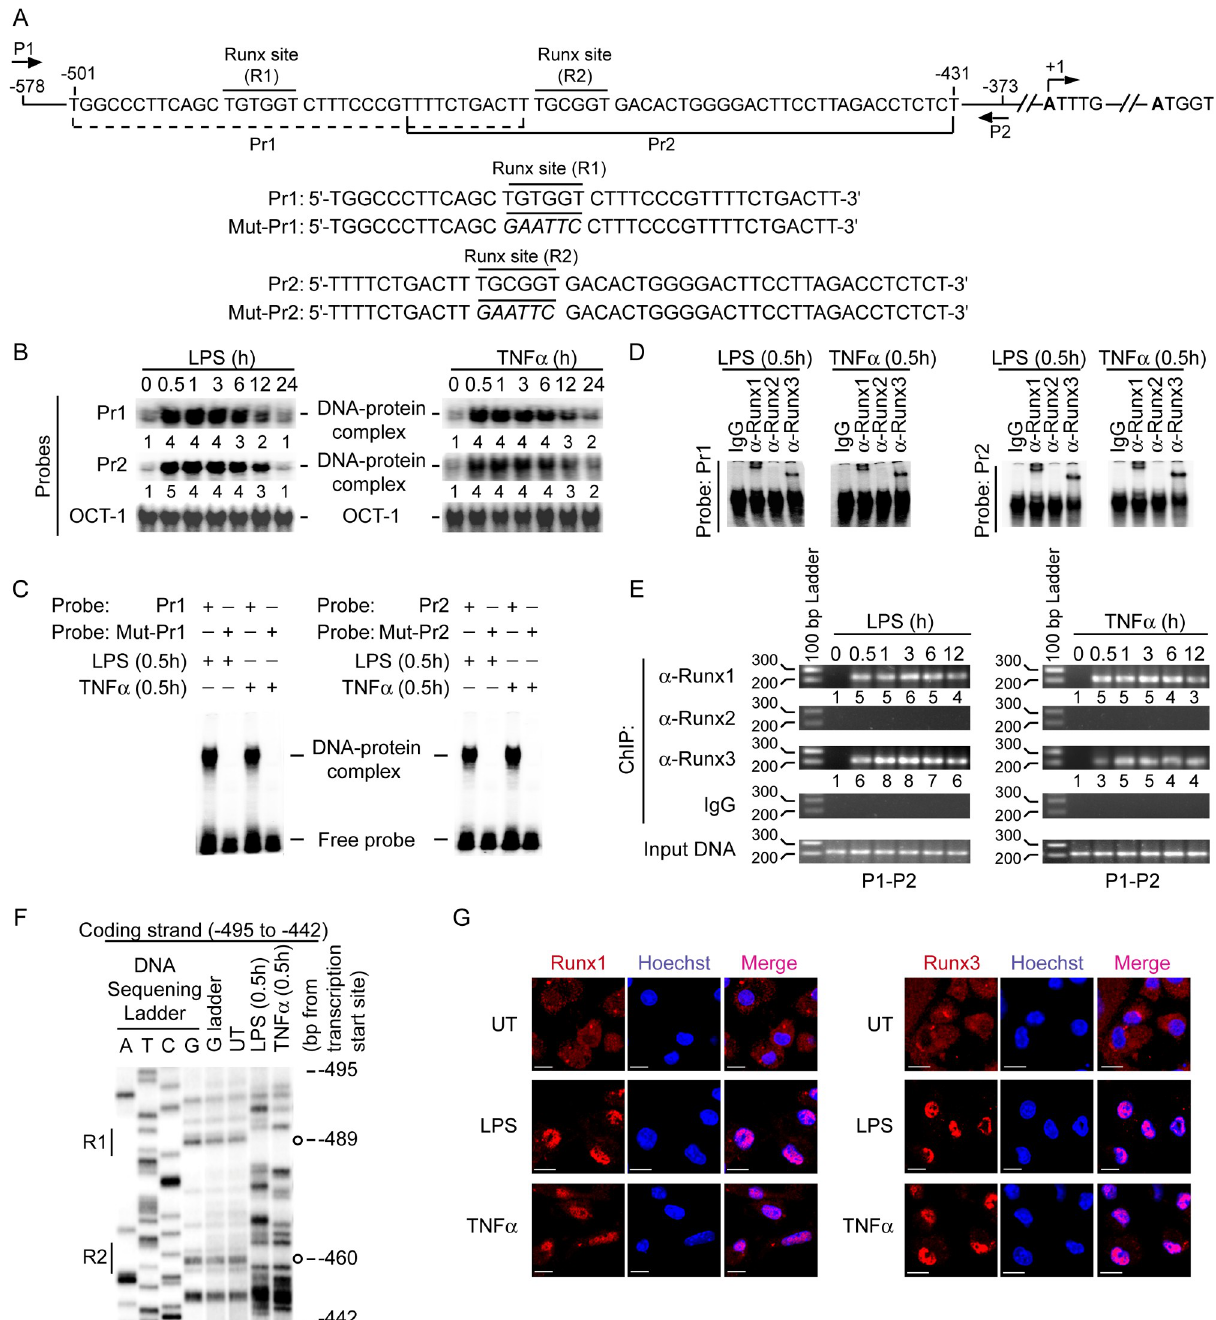
Fig 2. LPS and TNF α induce nuclear localization and binding of Runx proteins to the CD40 promoter. (A) Schematic presentation of mouse CD40 promoter indicating the location of putative Runx-binding sites (R1 and R2) and ChIP primers (P1 and P2), and details of oligonucleotide probes used for EMSA. Mouse CD40 promoter-specific Pr1 and Pr2 probes contain putative wild-type Runx-binding sites, and Mut-Pr1 and Mut-Pr2 probes contain mutations (in italics) at Runx-binding sites. Base positions are relative to the transcription start site. (B and C) EMSA of nuclear extracts of BMDCs treated with LPS or TNF α for indicated times; assessed with indicated probes. Numbers below lanes in (B) represent densitometry [normalized to OCT-1 binding (control)] relative to that of untreated BMDCs (0 h). The densitometry results pooled from three independent experiments for (B) are shown in S2 Fig. (D) Supershift EMSA [with immunoglobulin G (IgG; control) or antibody to ( α -) Runx1, Runx2 or Runx3] of nuclear extracts of BMDCs treated with LPS or TNF α for 0.5 h; assayed with Pr1 or Pr2 probes. (E) Binding of Runx proteins to -578/-373 region of the CD40 promoter in BMDCs treated with LPS or TNF α (time, above lanes); assessed via ChIP using the primers shown in (A) and indicated antibodies (left margin). Amplification of mouse GAPDH promoter (S4 Fig) and chromatin immunoprecipitated by rabbit IgG were used as negative controls, and input DNA